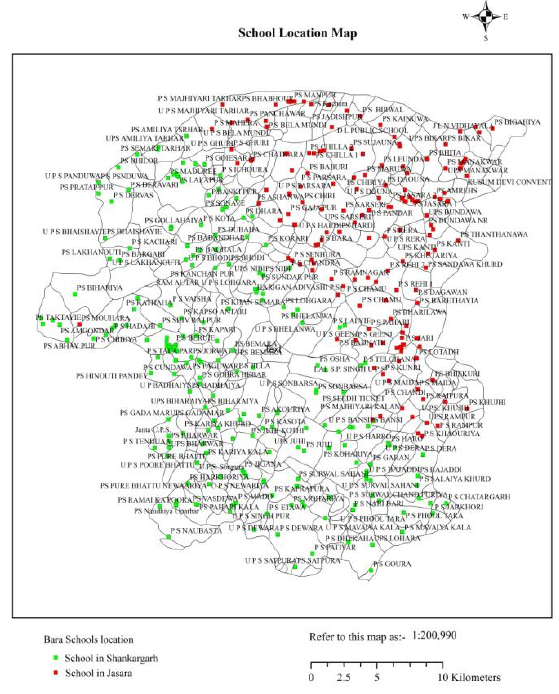
Figure 3. Bara tehsil schools location